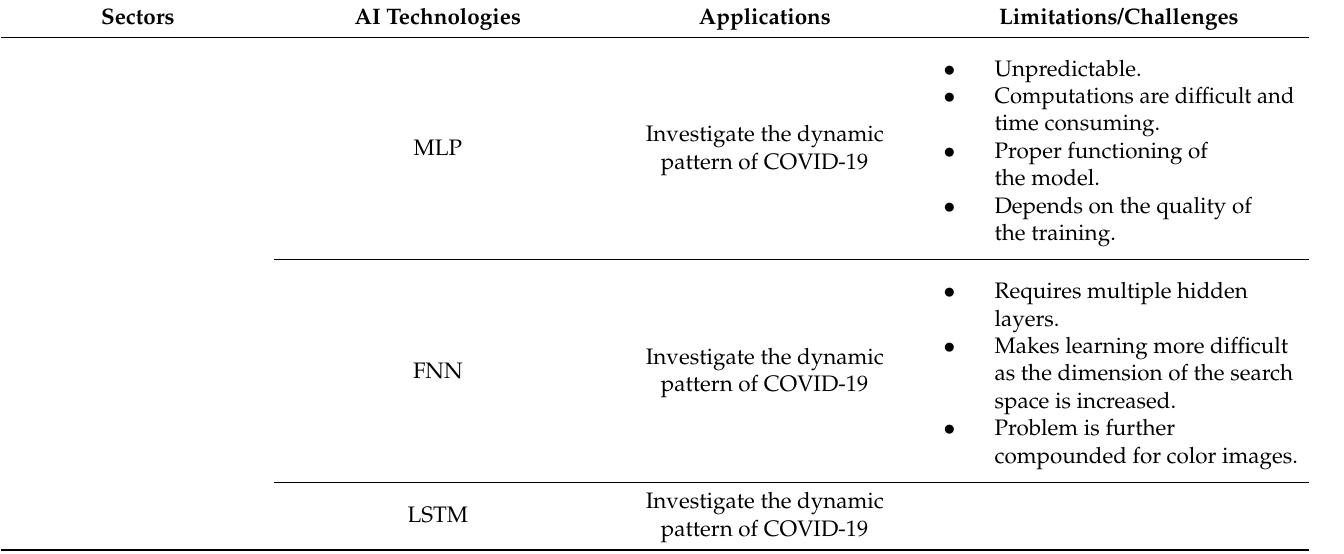
Table 1. Cont. Sectors AI